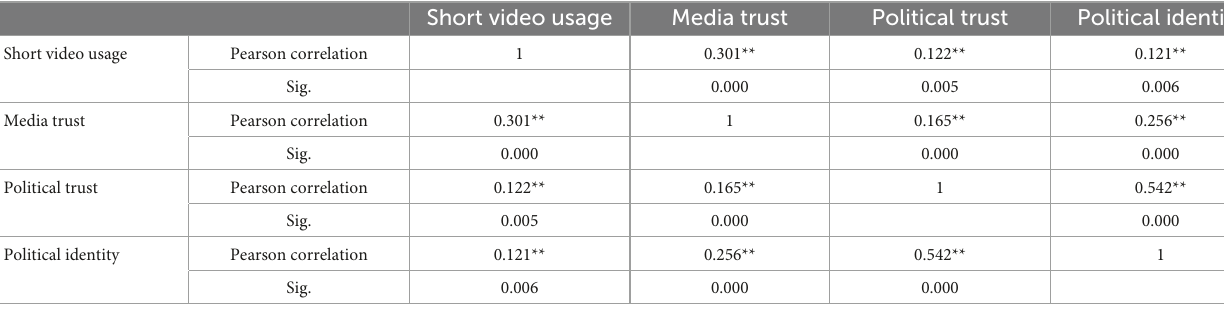
TABLE 2 Correlation of core variables.